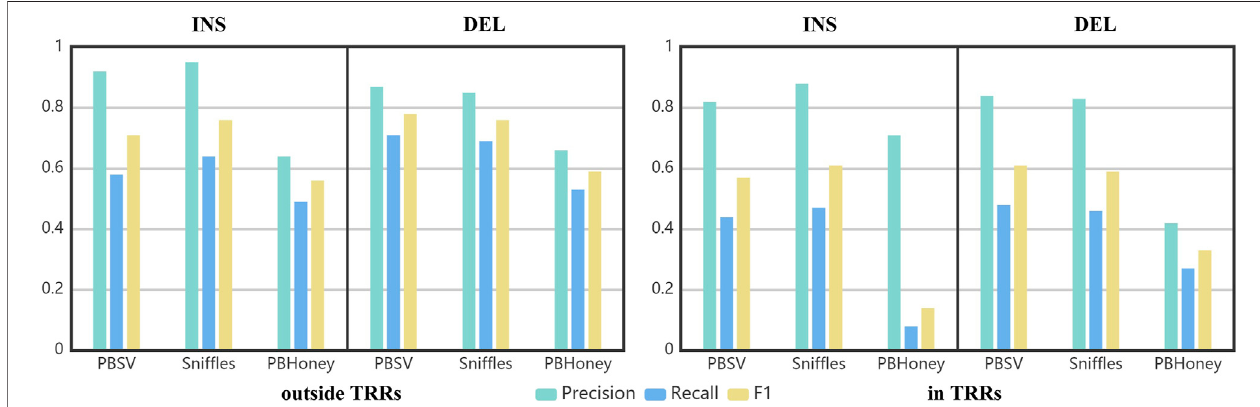
FIGURE 4 | The precision, recall and F1 of three pipelines in detecting insertions and deletions in/outside TRRs.